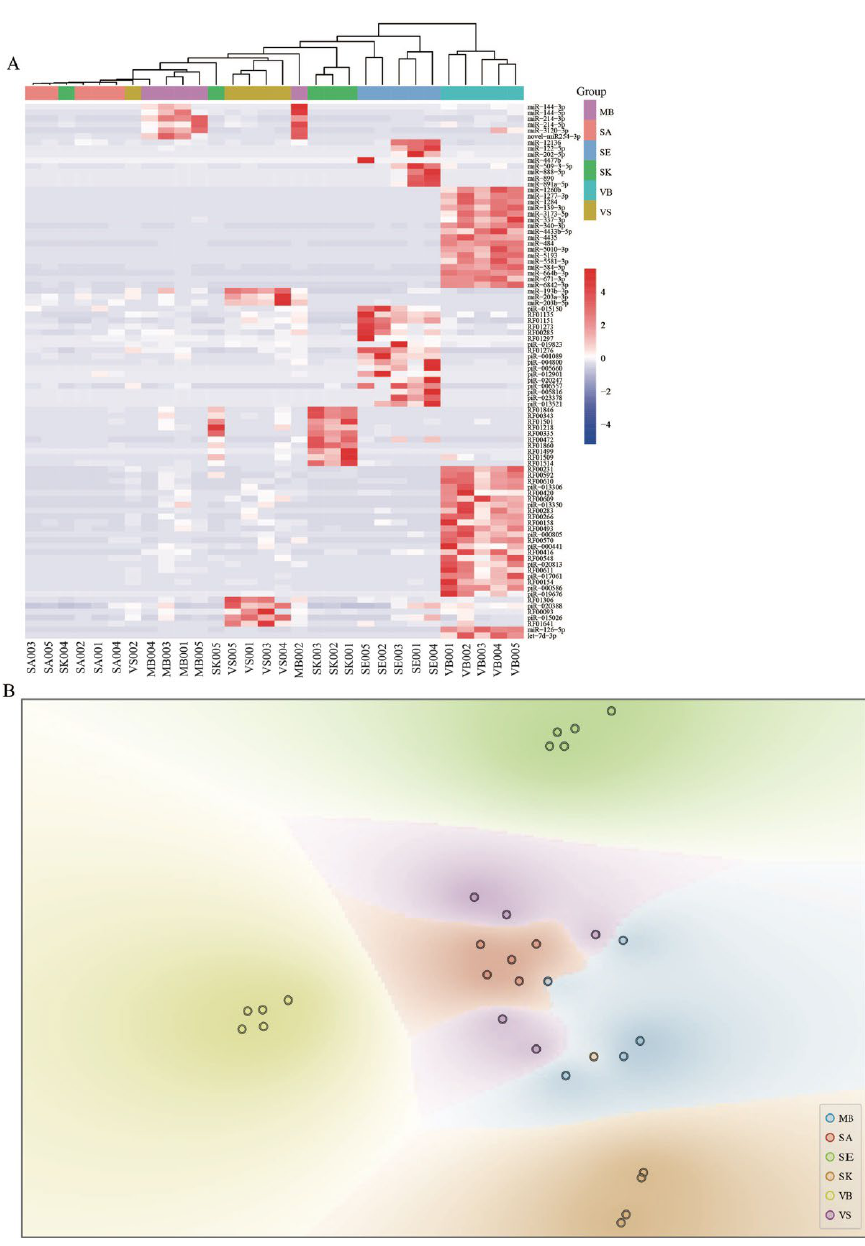
Figure 5. The expression patterns of the 90 ASMs screened in six forensic groups revealed by hierarchical clustering based on Euclidean distance ( A ) and unsupervised t-SNE method ( B ). Up until now, many body fluids/tissue-specific small RNAs have been reported for the six stains, most of which are miRNA (Table 2). Some potential markers described in this study overlapped with the publicly reported ones such as miR-144 and miR-214 for the MB group; miR-891, miR-888 for the SE group; miR-126, miR-484 for the VB group (Table 2), all of which have been verified repeatedly [17,18,52,63]. However, there were also some published miRNA markers that did not meet our criteria and were filtered out, resulting in no miRNA biomarkers for the SA and SK groups. Their expression level is